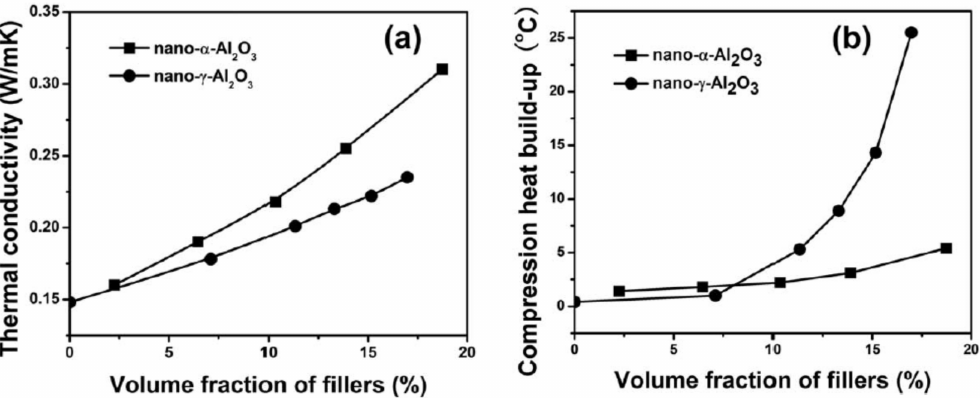
Figure 11. Trend of ( a ) thermal conductivity and ( b ) heat build-up properties of NR composites filled with α -Al 2 O 3 and γ -Al 2 O 3 nanoparticles [55]. Copyright© 2021 Society of Plastics Engineers. All rights